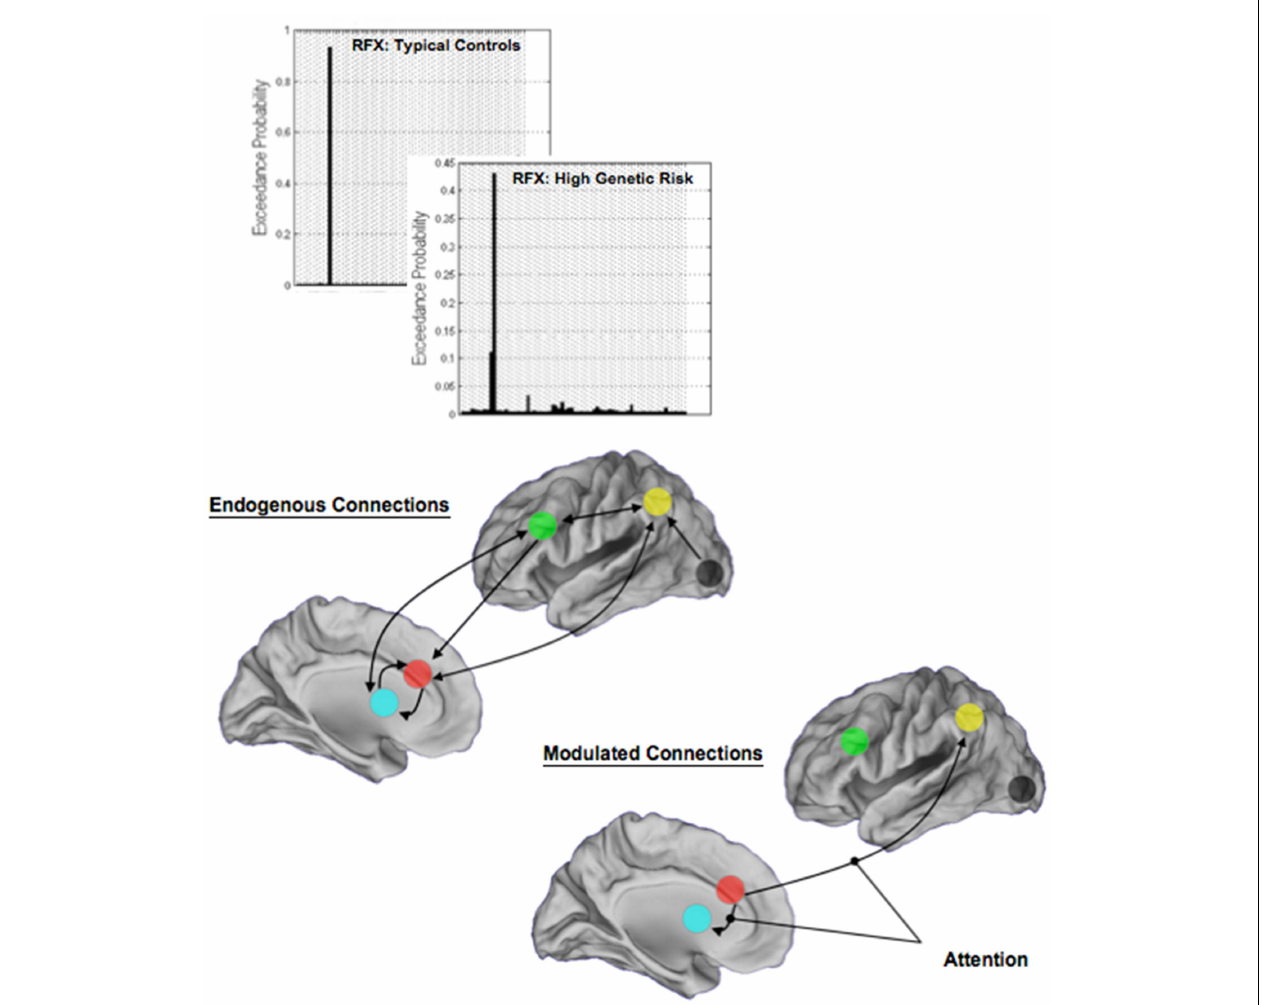
connections by attention are shown. Note that the primary modulated connections both originated in the dACC, terminating in the BG and the parietal cortex, respectively.The results of modulation suggest that dACC efferents may be particularly relevant in the implementation of attention in the modeled network of